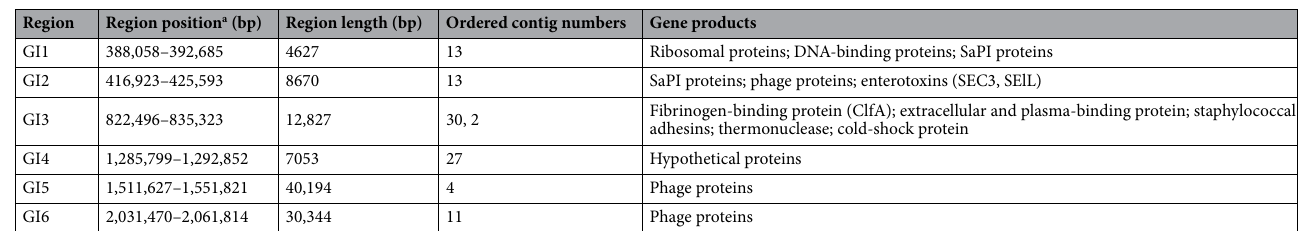
Table 4. Genomic islands identified in the HS-MSSA chromosome. a Identified genomic islands were over multiple contigs that were concatenated for IslandViewer4